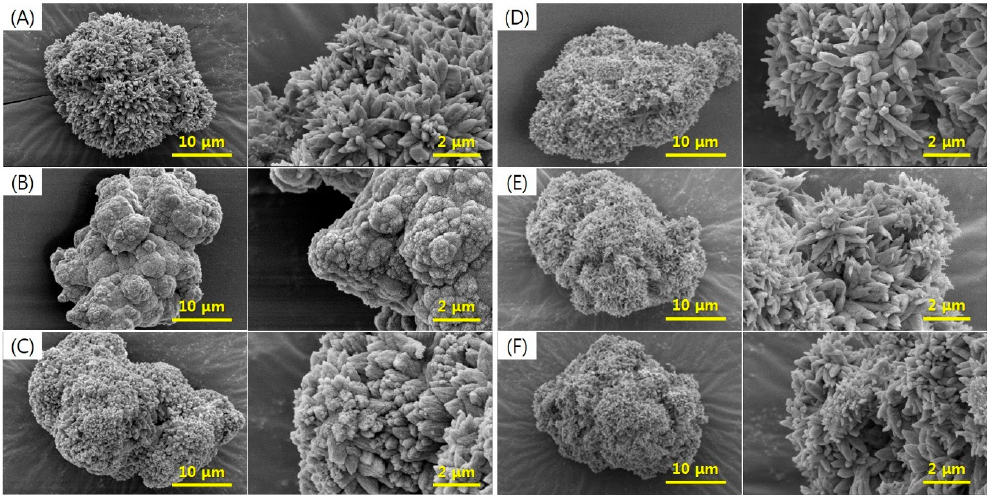
Figure 6. SEM images for the co-precipitated aragonite samples. ( A ) Control, ( B ) citric-arag, ( C ) malic-arag, ( D ) acetic-arag, ( E ) glutamic-arag, and ( F ) phthalic-arag.